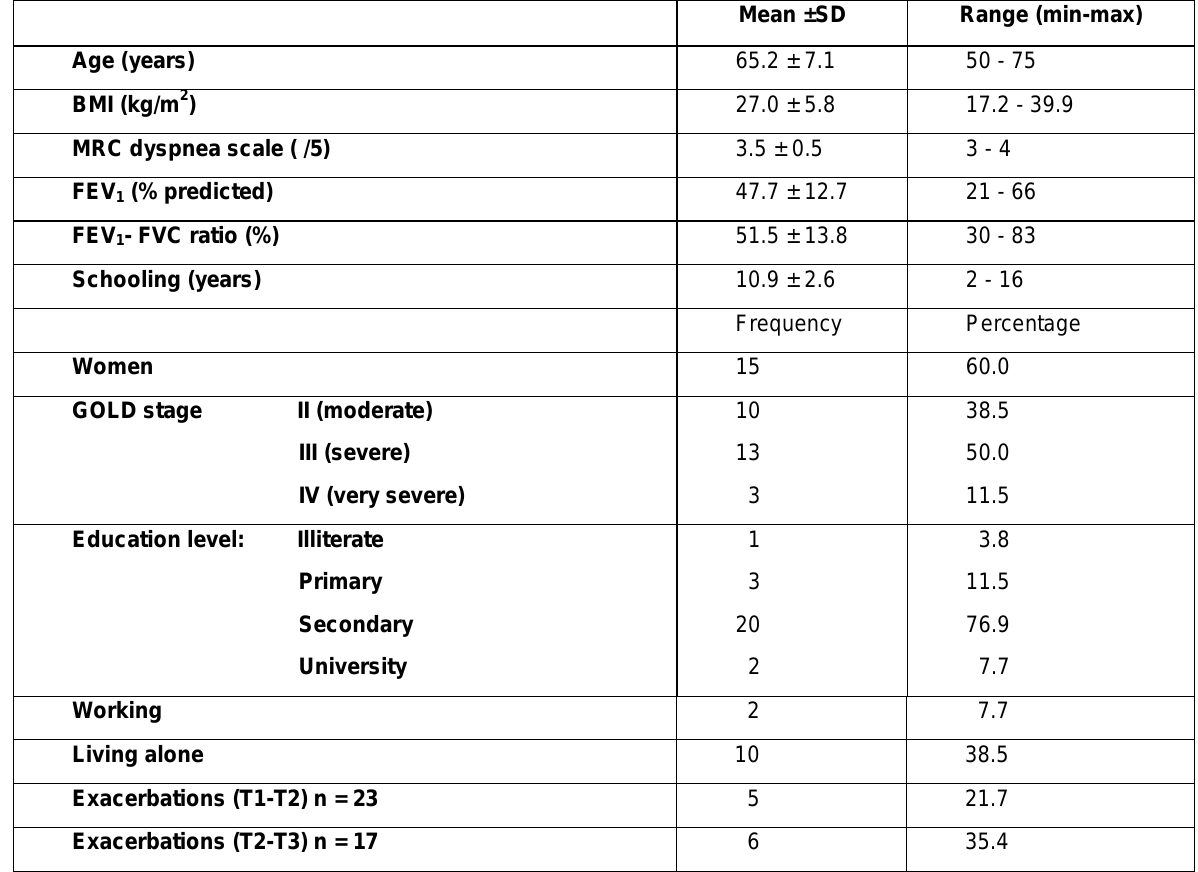
Table 2. Characteristics of the Study Participants